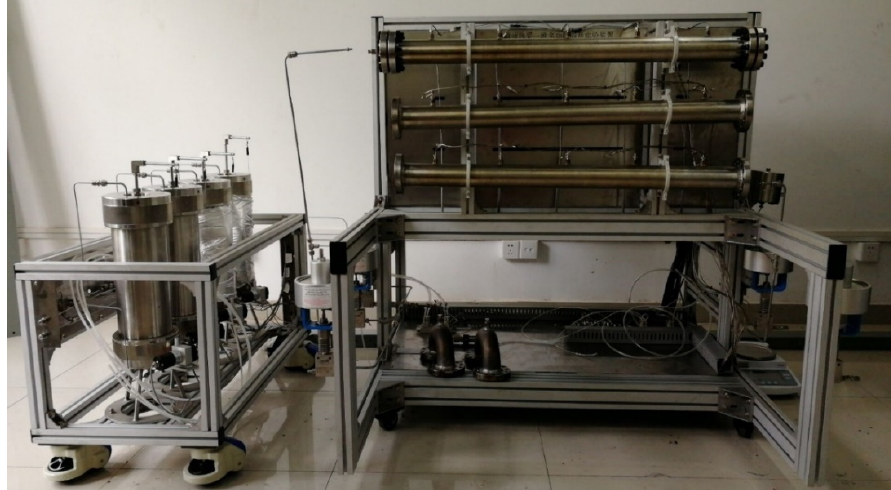
Figure A4. One-dimensional sand pack.